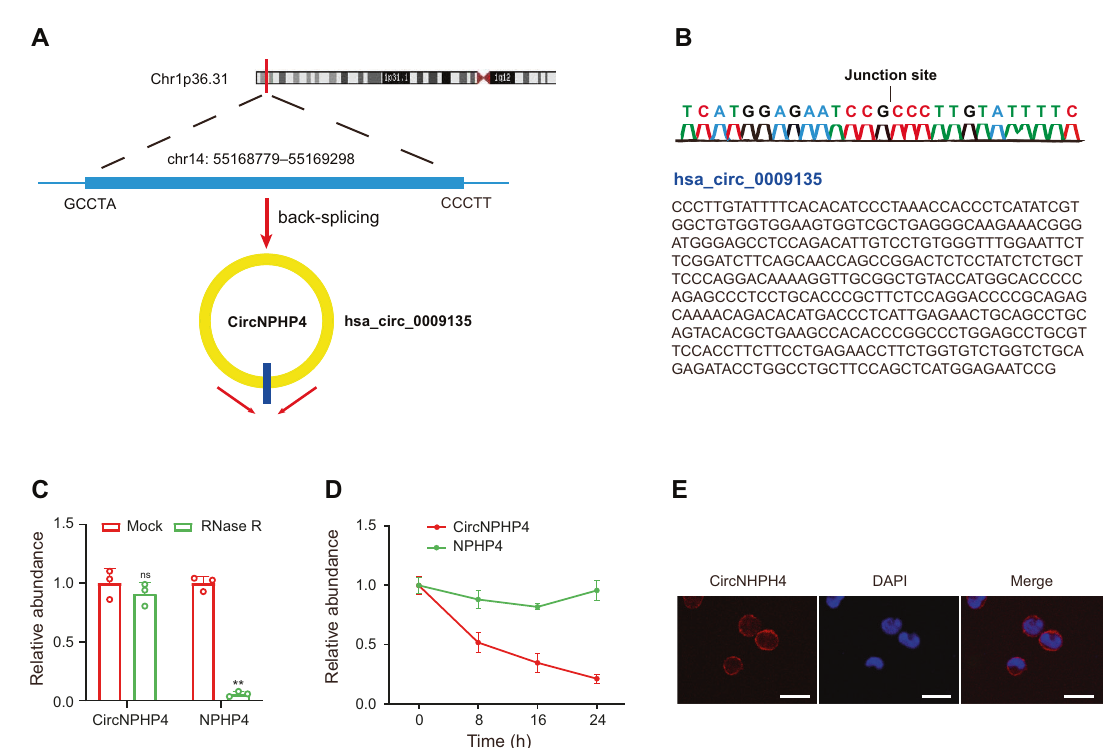
Fig. 4 Characterization of circNPHP4 in monocytes. A The genomic location of the hNPHP4 gene and of circNPHP4. B Sanger sequencing showing the “ head-to-tail ” splicing of circNPHP4 in the monocytes. C qRT-PCR quanti fi cation of circNPHP4 and hNPHP4 mRNA expression in monocytes after treatment with RNase R. D qRT-PCR quanti fi cation of circNPHP4 and hNPHP4 mRNA expression in monocytes after treatment with Actinomycin D. Data are presented as means ± SD; signi fi cant difference was identi fi ed with Student ’ s t test. * P < 0.05; ** P < 0.01; ns (not signi fi cant). E RNA FISH for circNPHP4. Nuclei were stained with DAPI. Scale bar = 20